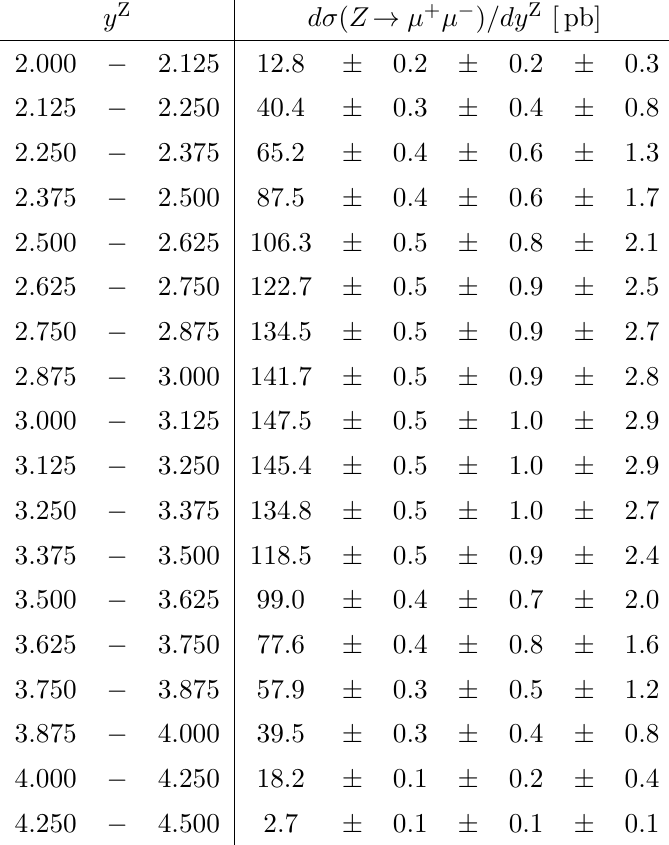
Table 14 . Measured single differential cross-sections in interval regions of y Z . The first uncertainty is statistical, the second systematic, and the third is due to the